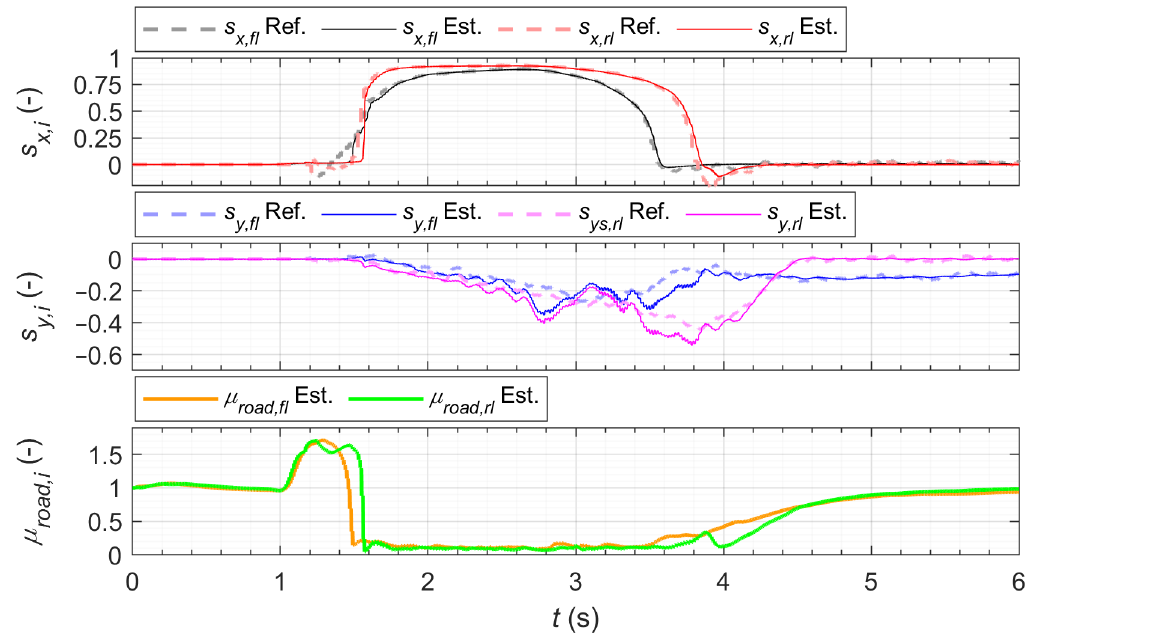
Figure 4. Test data—acceleration on a wet road surface: measured and estimated tire slip for front left and rear left wheels as well as estimated tire model adaption parameter.